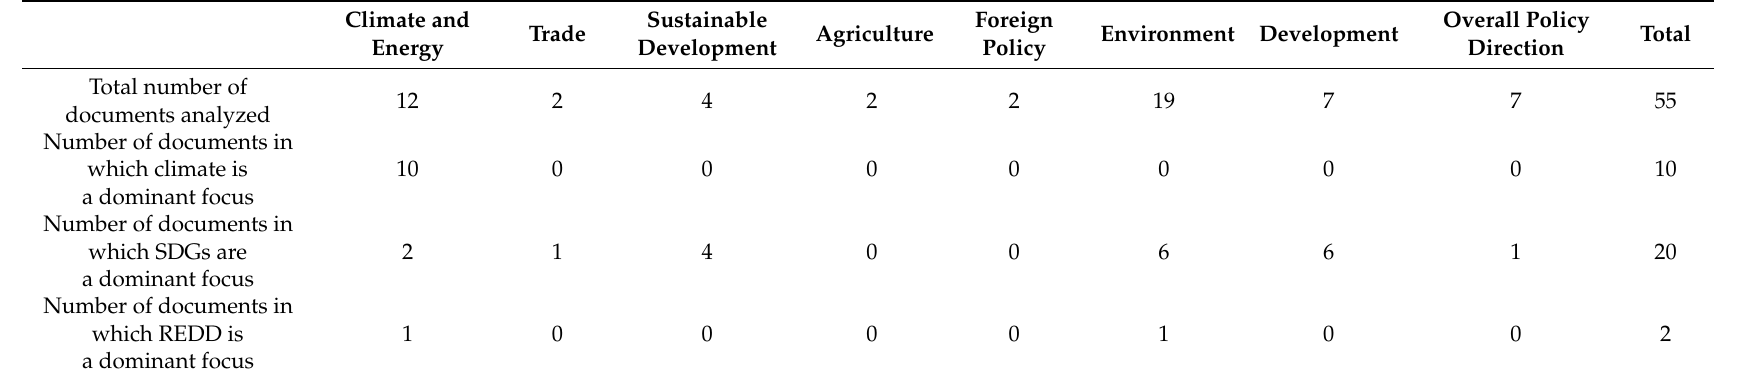
Table 1. Emphasis given to action on climate change, the SDGs and REDD+, in relevant EU policy